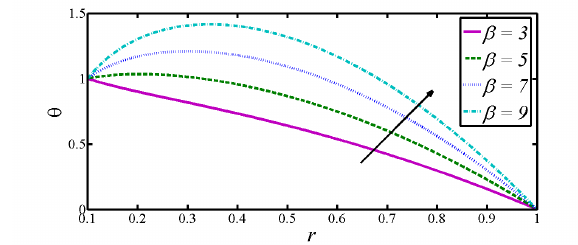
Fig. 2: The temperature profile for different values of heat genera- tion